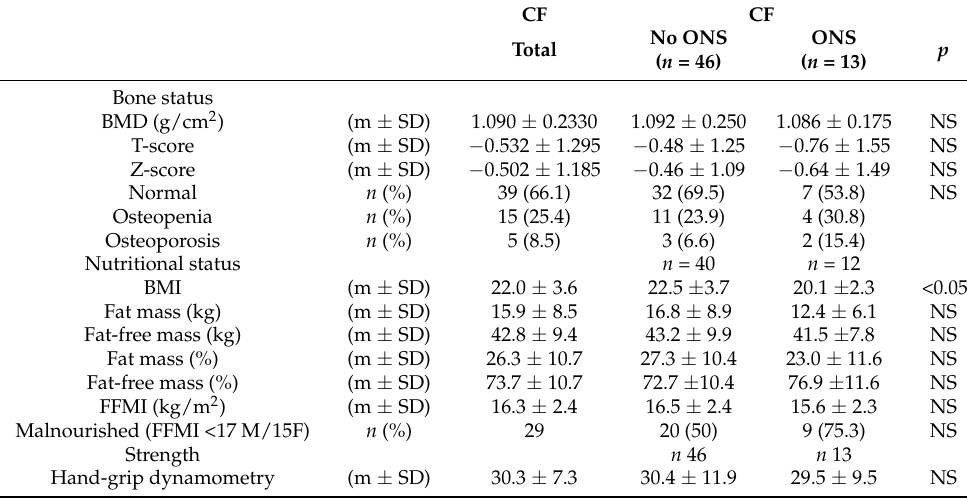
Table 2. Bone and nutritional status.